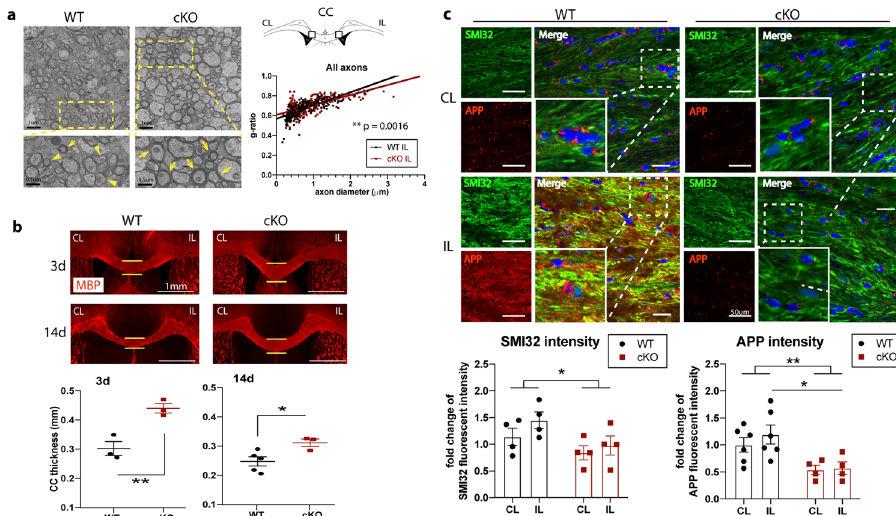
Fig. 6 Microglial Nhe1 cKO mice exhibited increased white matter resistance to ischemic stroke. a Representative images and g-ratio from axons in the medial corpus callosum (CC) by transmission electron microscopy (TEM). N = 30 myelinated axons per image, 3 images per animal, from 3 biological independent animals per group; totaling ~270 myelinated axons per group. Slopes from the linear regressions in WT or cKO mice were compared. b Increased CC thickness (at same bregma level) in Nhe1 cKO mice at 3 and 14 d post-stroke by MBP staining. N = 3 – 5 animals. c Representative images and quantitative analysis of SMI32 and APP intensity in CL and IL peri-lesion area of CC from WT or Nhe1 cKO mice at 3 d post-stroke. N = 4 – 6 animals. Data are mean ± SEM. * p < 0.05, ** p <